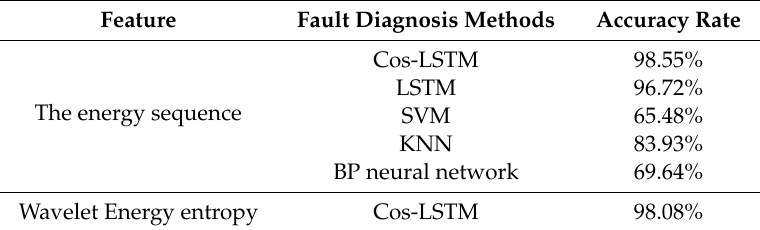
Table 3. Comparisons with other classic fault diagnosis methods.